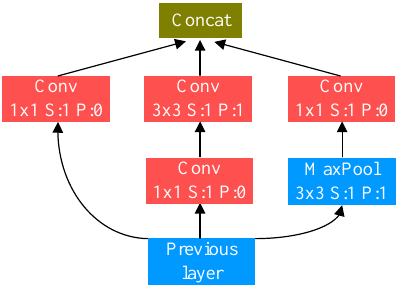
Figure 3. Common structure of a feature extraction module.